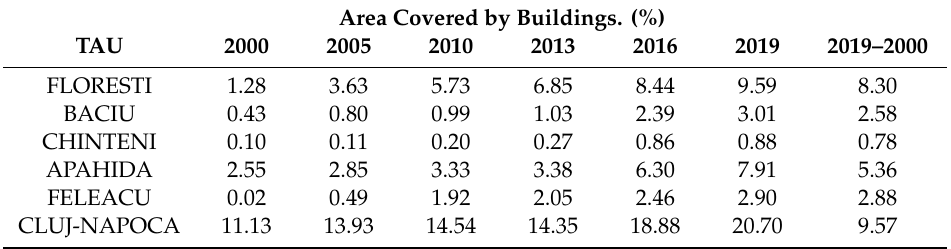
Table 2. Analysis of the surfaces occupied by constructions in the 2000–2019 period. Area Covered by Buildings.